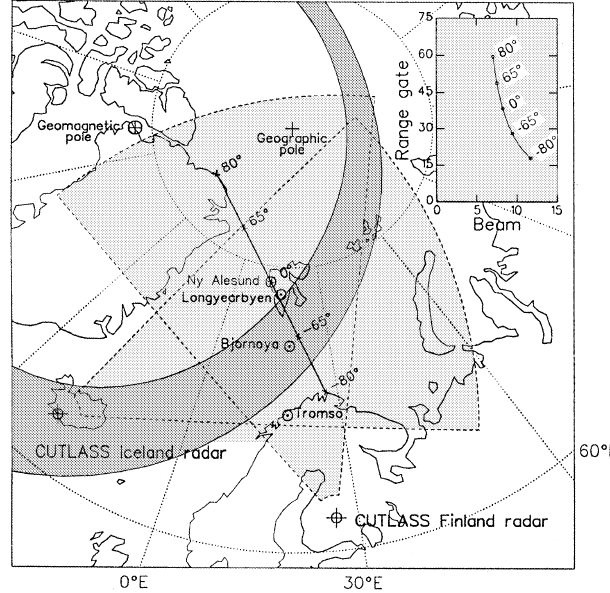
Fig. 1. The locations of the fields-of-view of the CUTLASS radars and the meridian of the Ny A˚ lesund MSP, projected to 250 km altitude. Numbers to the right of MSP meridian indicate the location of the projection of zenith angles 0 (cid:176) , 65 (cid:176) and 80 (cid:176) . Also illustrated is the statistical location of the quiet (cid:133) K p (cid:136) 1 (cid:134) auroral oval at 01 UT. The IMAGE magnetometer site at Bjørnøya is indicated as well as the EISCAT sites Tromsø and Longyearbyen for reference. The inset panel indicates the mapping of the MSP meridian into the beam/gate coordinates of the Finland radar field-of-view; this information is employed for the mapping of radar backscatter onto the MSP meridian in